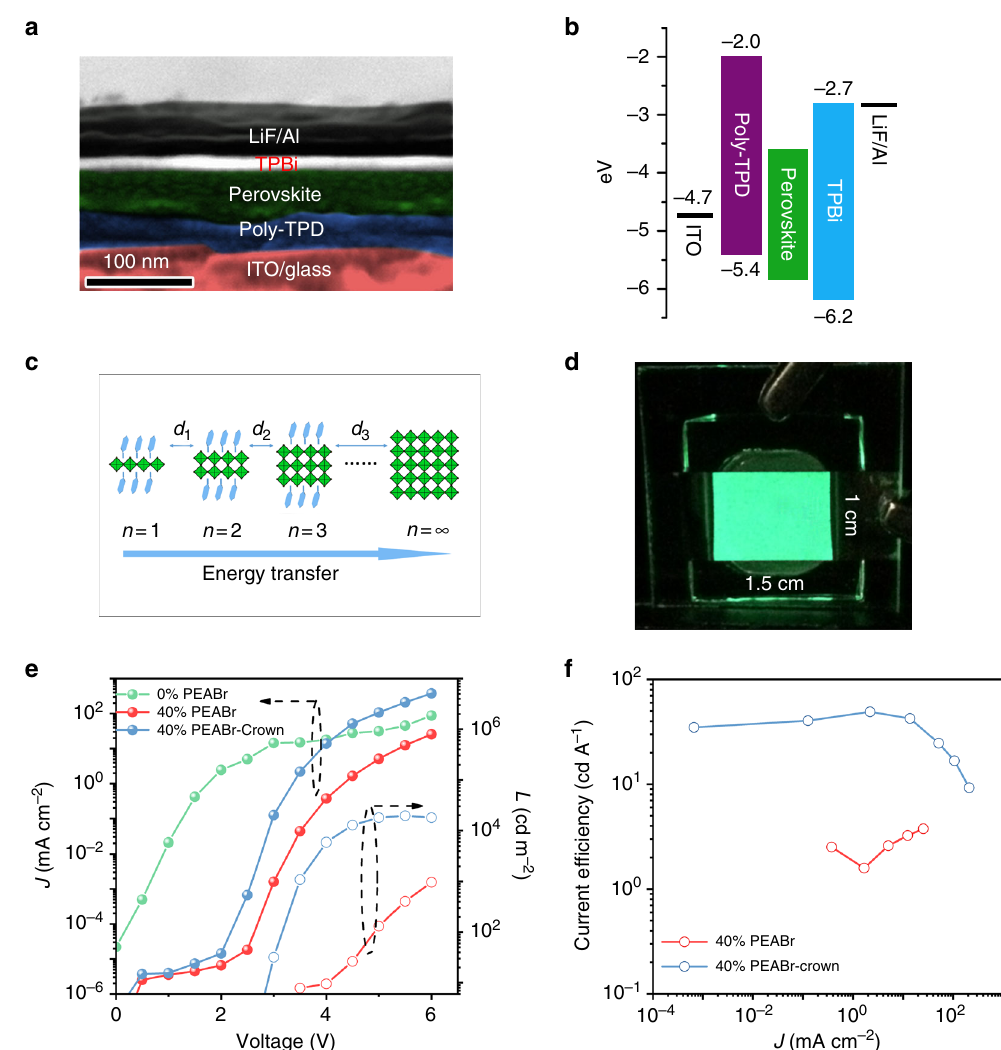
Fig. 3 Performance characterization of the LED devices. a SEM cross-sectional image. b Energy diagram of the LED device structure. In the energy diagram, the bandgap energy difference between 2D and 3D is not considered. The energy levels of organic semiconductor layers are taken from literature 6 . c A cartoon image shows the energy funnel transfer from thin layer with large bandgap (small n ) to thick layer with small bandgap (larger n ), the distances ( d: d , d , … , d n ) ) between them play a key role on funnel transfer ef fi ciency. d A photograph of operating 40% PEABr-crown LED device with an emitting size 1 2 of 1.5 × 1 cm 2 driven at a bias of 3 V. e J – V – L data and f current ef fi ciency of devices based on the perovskite fi lms 0% PEABr, 40% PEABr, and with